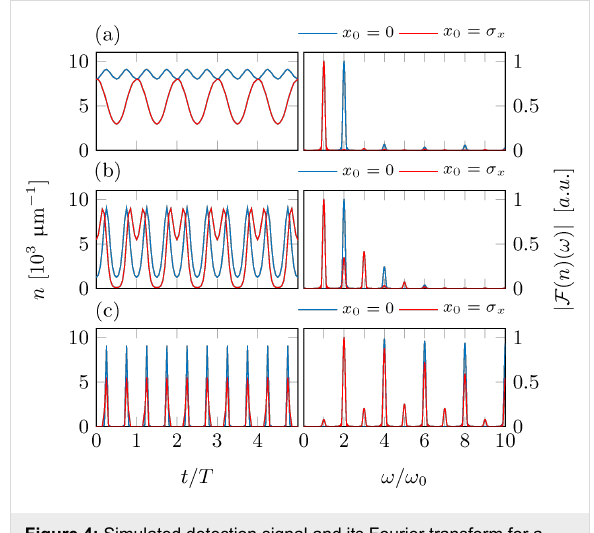
Figure 4: Simulated detection signal and its Fourier transform for a detector based on local density probing, as derived from a numerical simulation of a cold atom tip ( N = 5 × 10 5 , T = 500 nK) oscillating in an harmonic potential ( ω 0 = 2 π × 50 Hz). The oscillation amplitudes A have been set to (a) 0.5 σ x , (b) 2 σ x and (c) 200 μ m. The outcoupling positions x 0 are fixed to 0 (blue solid lines) and σ x (red solid lines).